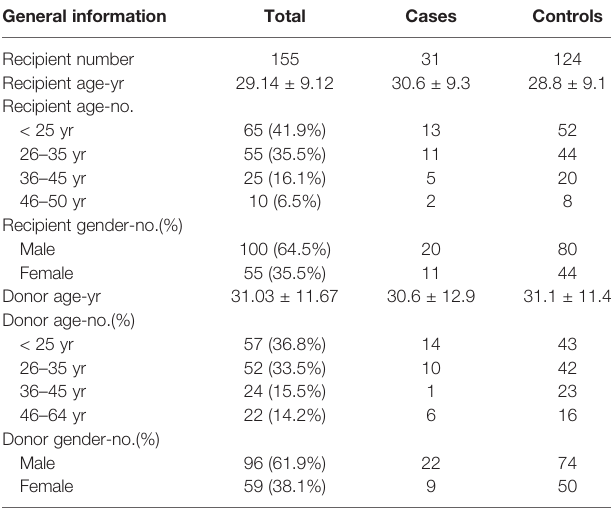
TABLE 1 | Basic characteristics of 155 patients included in this